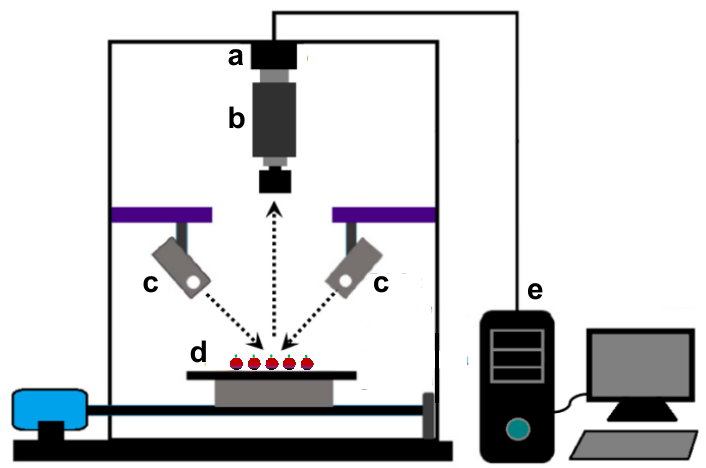
Figure 1. Hyperspectral imaging system: ( a ) a charge-coupled device (CCS) camera, ( b ) a spectrograph with a standard C-mount zoom lens, ( c ) quartz tungsten halogen (QTH) lighting unit, ( d ) translation stage, and ( e ) a PC with image acquisition software.